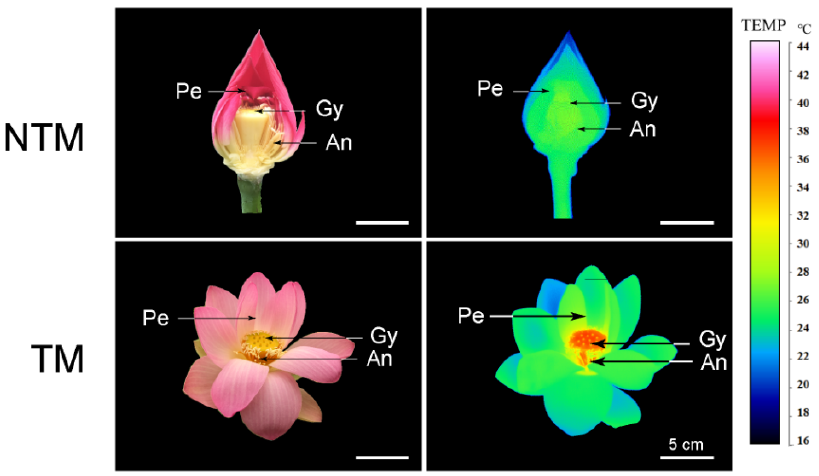
Figure 1. Photographs ( left ) and infrared thermal images ( right ) of N. nucifera flowers at the non-thermogenic (NTM; bud) and thermogenic (TM; female) stages. Temperatures in the infrared images are color coded, with red and green indicating higher and lower temperatures, respectively, in the receptacle. Pe, petal, Re, receptacle, An, anthers. Scale bars, 5 cm.